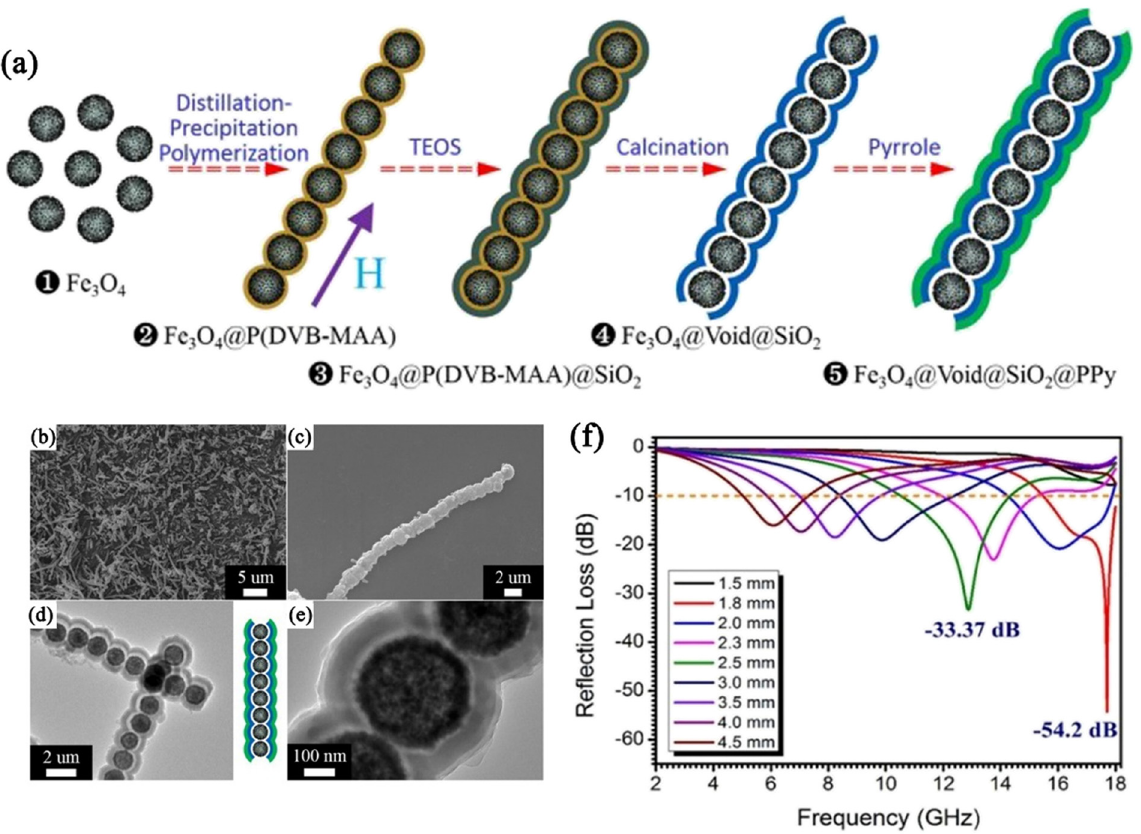
Figure 10: ( a ) Schematic diagram of the preparation of Fe 3 O 4 @void@SiO 2 @PPy nanochains, SEM ( b and c ) and TEM images ( d and e ) of Fe 3 O 4 @void@SiO 2 @PPy nanochains, and ( f ) microwave re fl ection loss curves of the composites [ 70 ] ; Copyright: 2020 with permission from